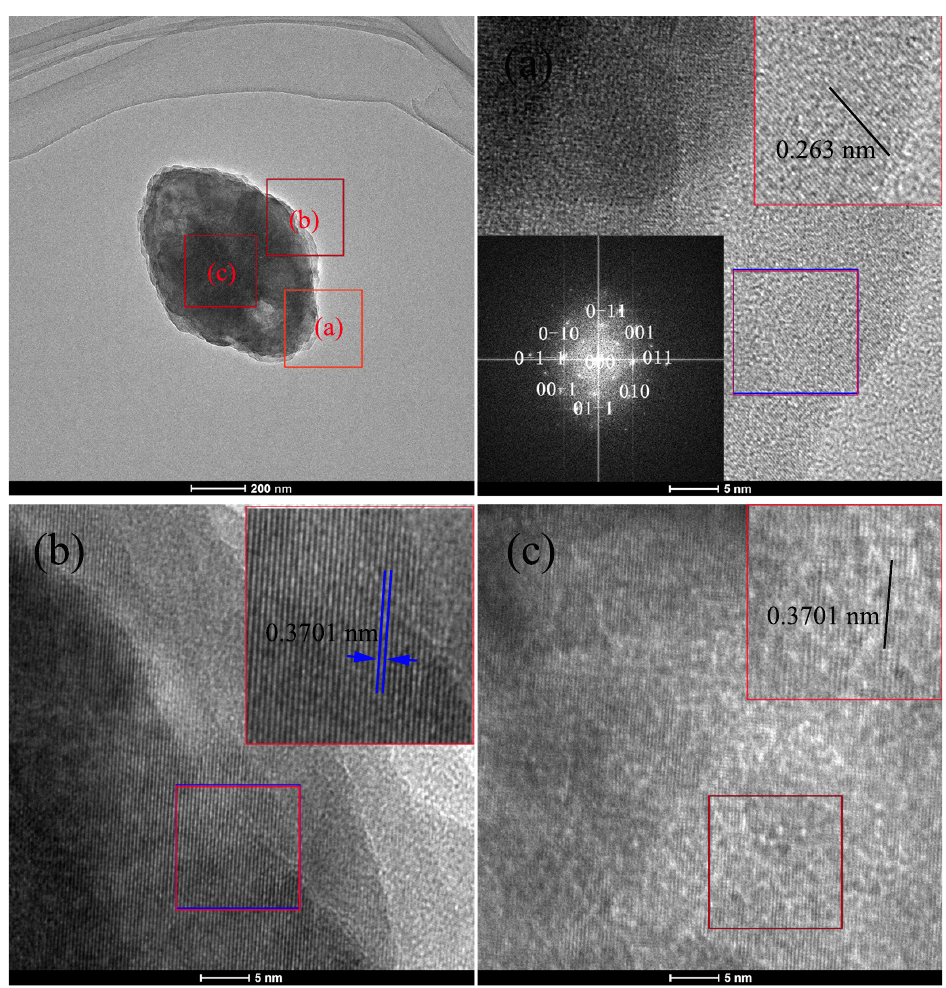
Figure 6. HRTEM and SEDA images of HT-ZrO 2 (0.02) particle with diamond-like shape. HRTEM images at the edge of the long axis ( a ), the edge of the short axis ( b ) and the particle center ( c